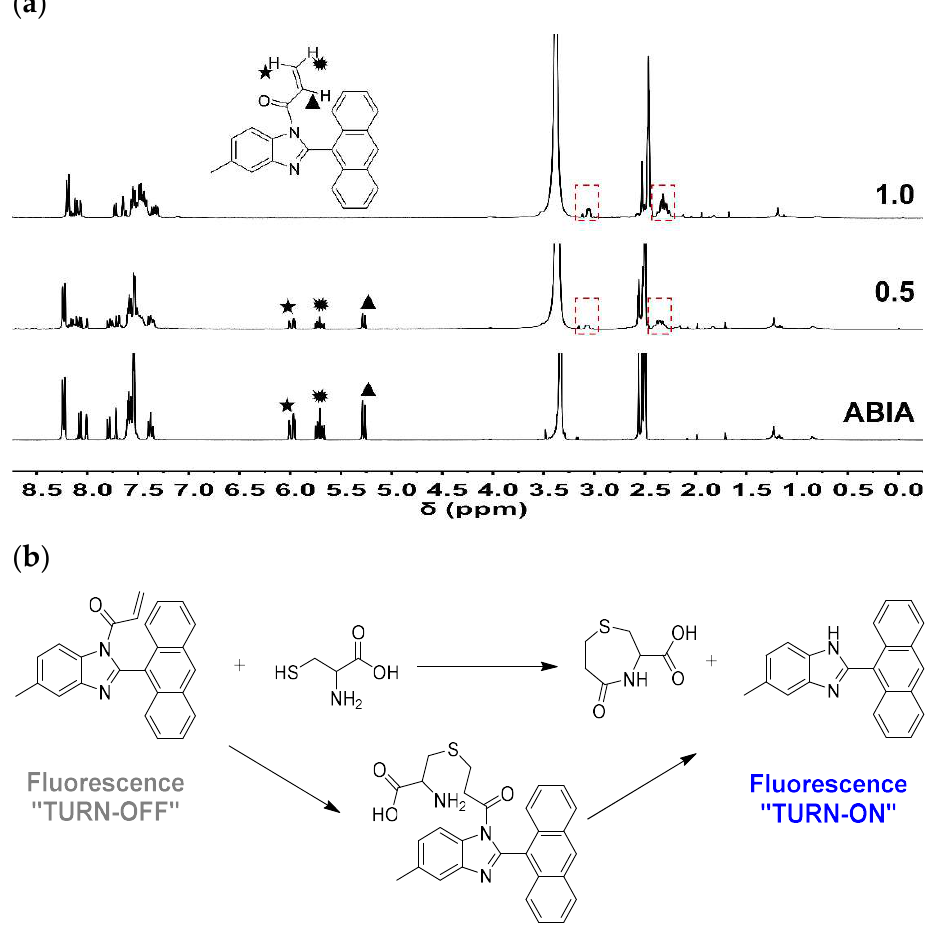
Figure 3. ( a ) Changes in 1 H NMR spectra of ABIA upon the addition of 0.5 and 1.0 equivalents of Cys in 90% DMSO- d 6 :0.01 M HEPES buffer solution (D 2 O); ( b ) proposed Cys detection mechanism by ABIA .